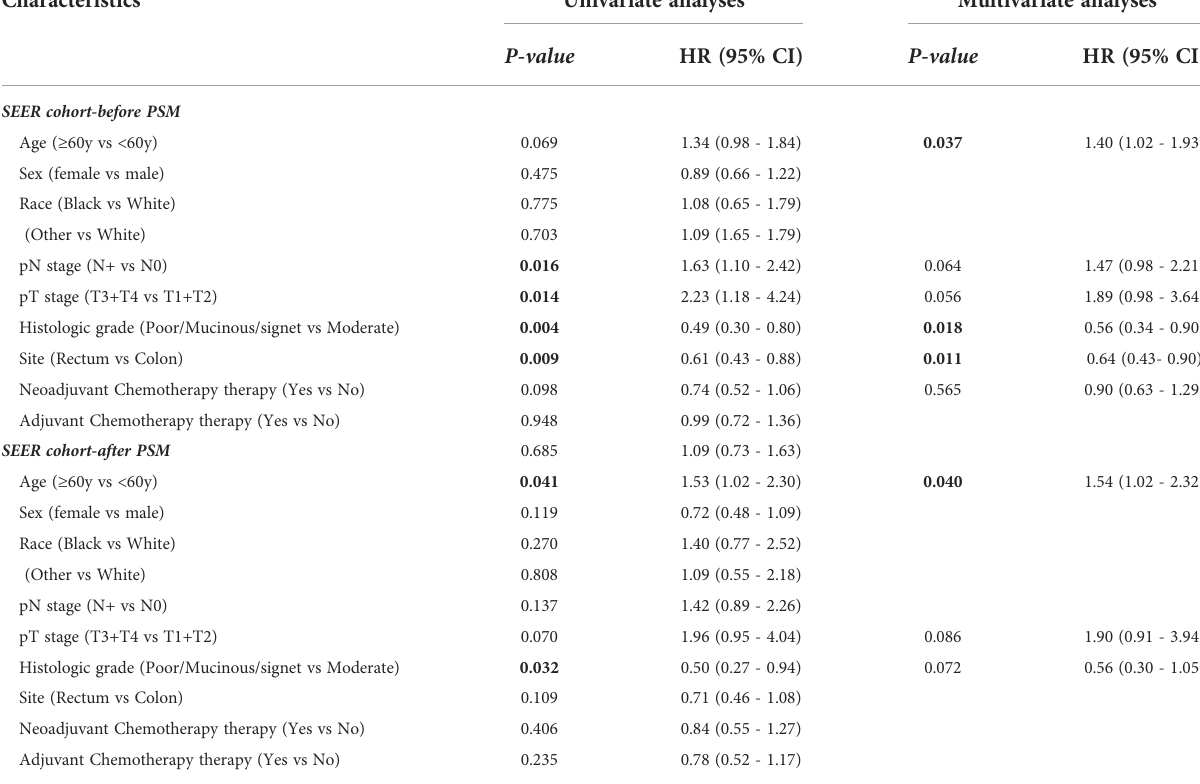
TABLE 3 Prognostic factors for OS in CRLM patients in SEER cohort. Characteristics Univariate analyses Multivariate